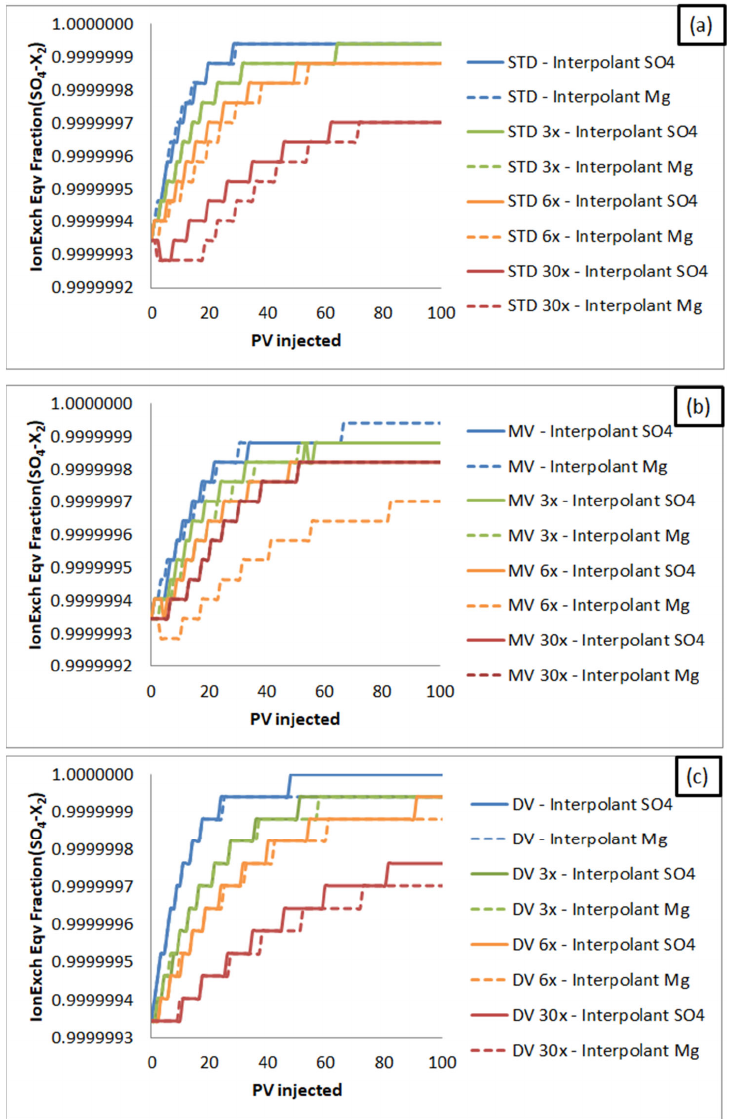
Figure 11. Ion Exchange Equivalent Fraction (SO 4 ‐ X 2 ) variation in the grid block {1,1,1} for brine injection: ( a ) STD; ( b ) MV and ( c ) DV.